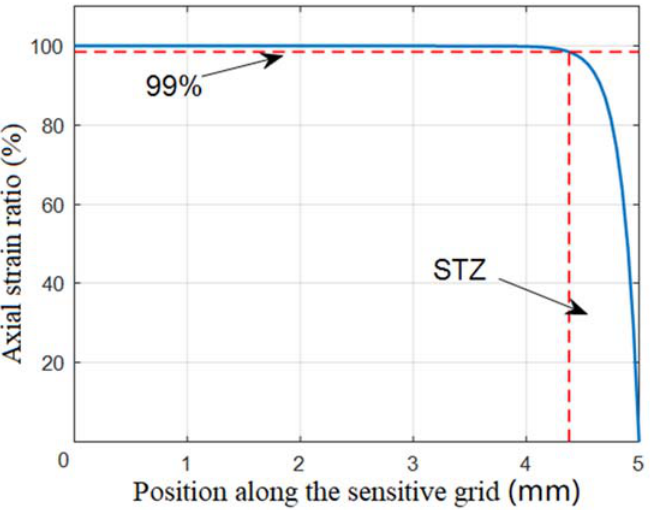
Figure 3. The axial strain distribution within resistance strain grids.